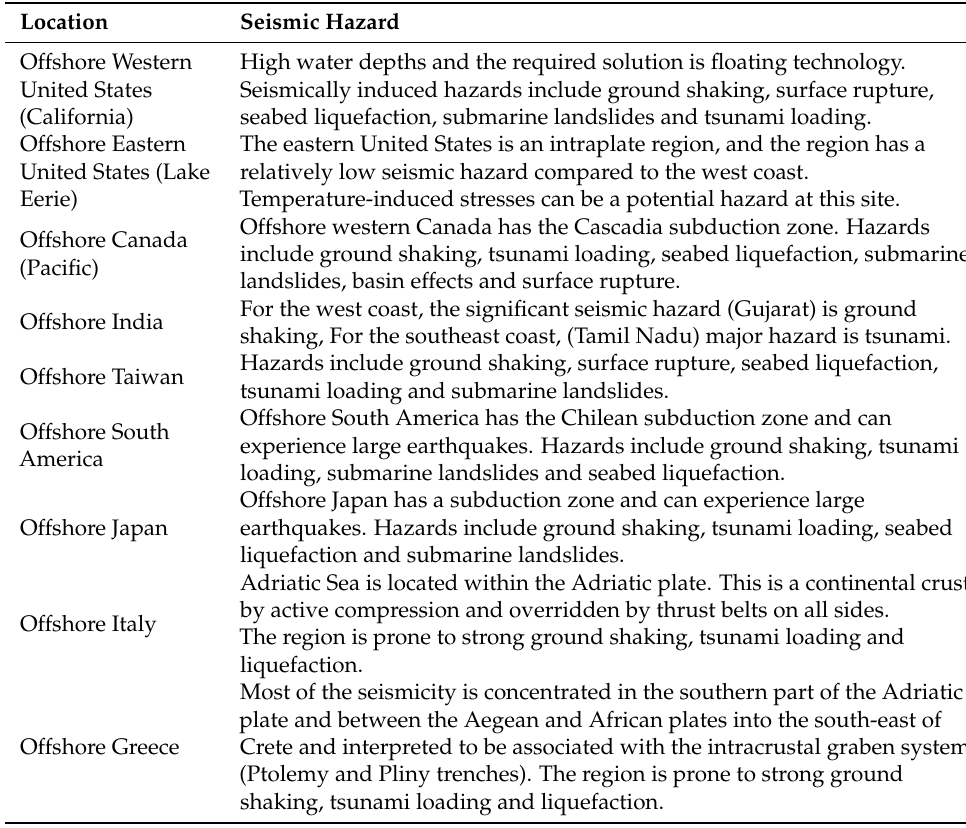
Table 1. Seismic hazards for potential seismic